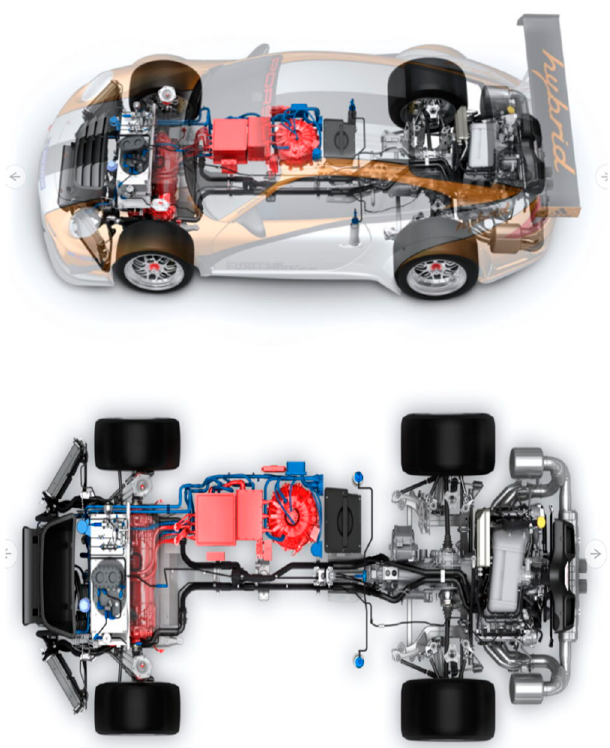
Figure 14. Top-down illustration of the GT3 R Hybrid’s powertrain. GT3 R Hybrid Porsche